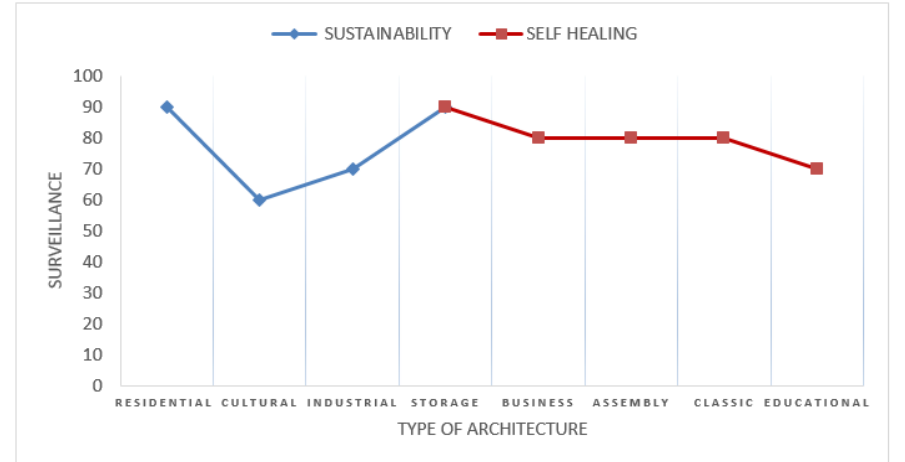
Fig. 9. Different type of architectures being evaluated for sustainability and self-healing mechanism in terms of smart material factor (by researchers).